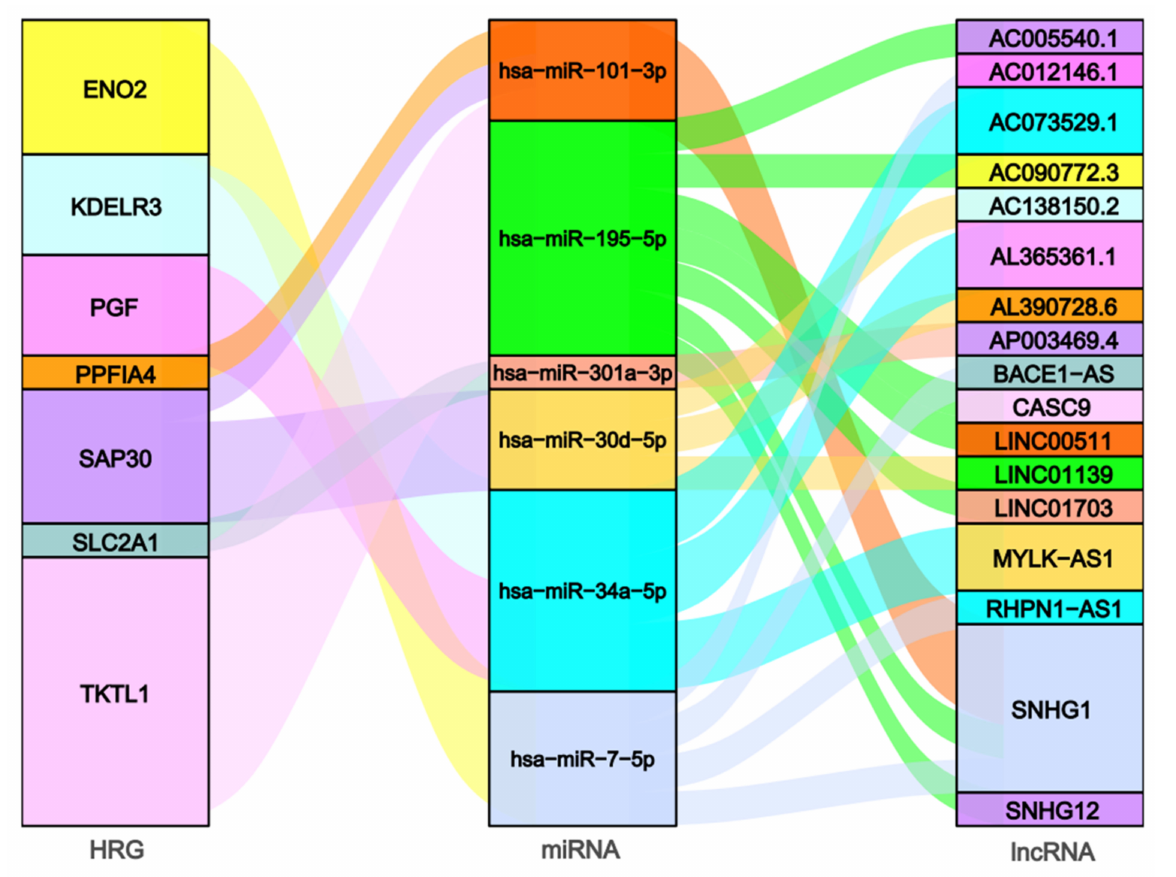
Figure 4. LncRNA-miRNA-mRNA network for hypoxia-related prognosis of hepatocellular